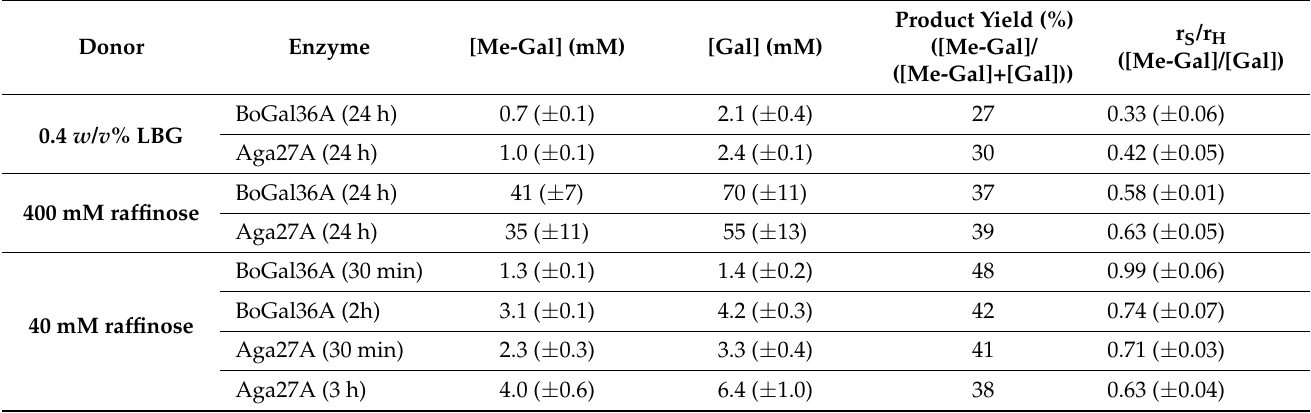
Table 4. Comparative table of transglycosylation capacity of Bo Gal36A and Aga27A with methanol as acceptor and raffinose or LBG as a